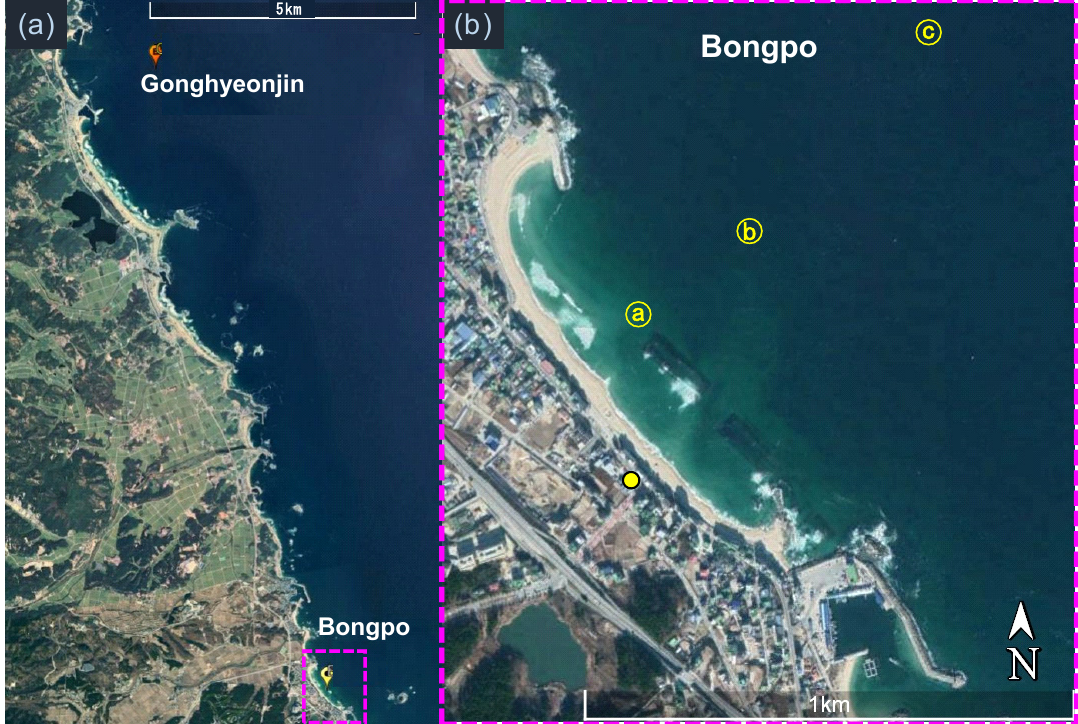
Figure 1. Locations of ( a ) Gonghyeonjin and Bongpo and ( b ) zoom-in of Bongpo beach. The yellow circle denotes that location of the video monitoring system (VMS).